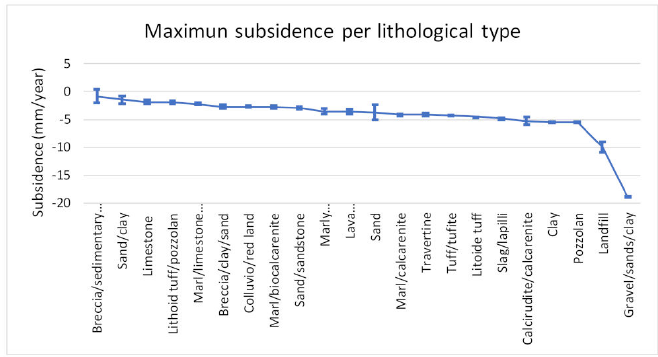
Figure 12. Graph subsidence per lithological type for highway